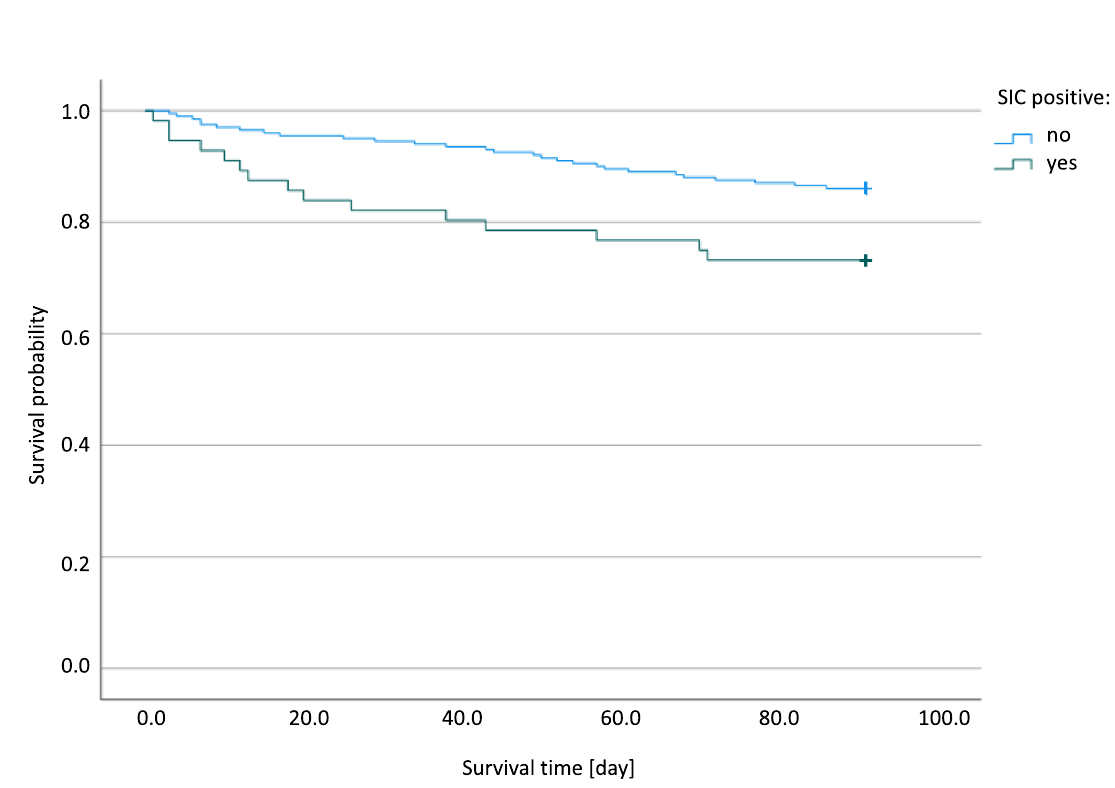
Fig. 2 Kaplan–Meier plots of patients included in the HYPRESS trial [15]: 90-day survival ( p patients who were SIC positive at least once during the observation period. SIC sepsis-induced